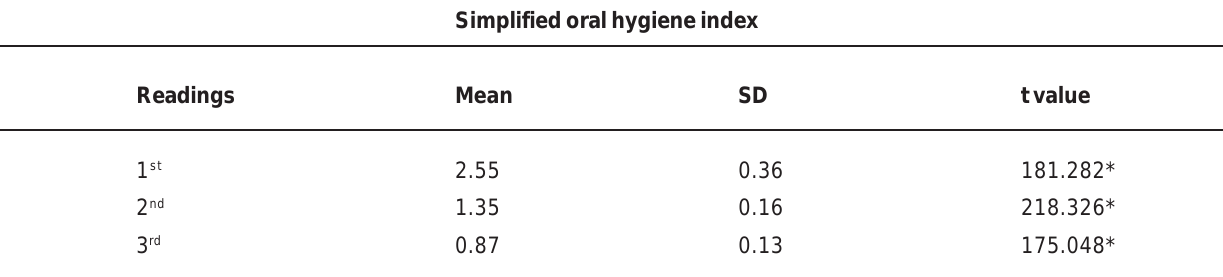
TABLE 4 - Relationship among the three readings of the simplified oral hygiene index examinations on children and adolescents of public schools of Maringa, Brazil.